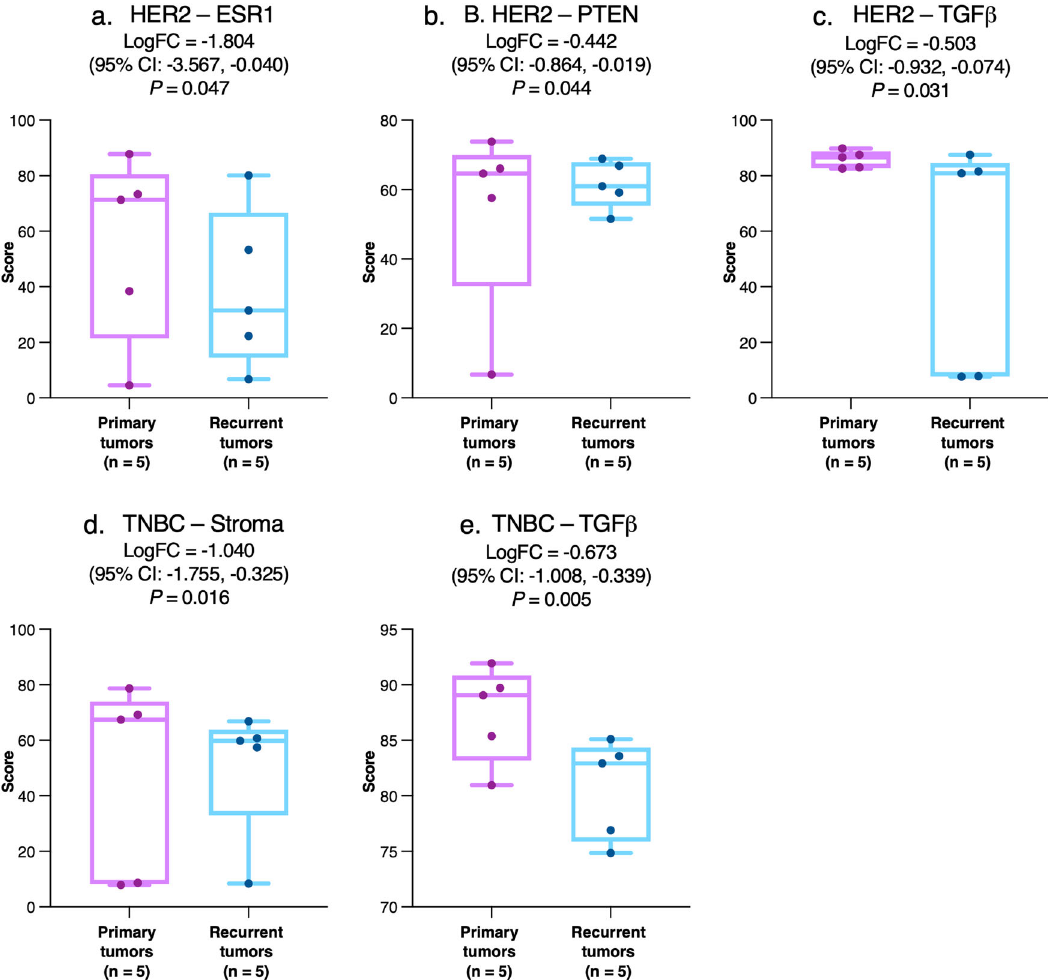
Fig. 6 Intraindividual comparison of tumor gene expression between matched primary tumors and post-pCR recurrences that were HER2-positive or TNBC. For the HER2 subgroup, data are shown for estrogen signaling ( a ), PTEN ( b ), and TGF β ( c ) while for the TNBC subgroup, data are shown for stromal signaling ( d ), and TGF β ( e ). The central line indicates the median, the box indicates the 25 th and 75 th percentiles and the whiskers indicate the range. Circles represent individual data points. Negative values for logFC indicate lower expression in patients with relapse versus controls. Abbreviations: CI con fi dence interval, ESR1 estrogen receptor 1, logFC log 2 -fold change, PTEN phosphatase and tensin homolog, TGFß transforming growth factor beta, TNBC triple-negative breast